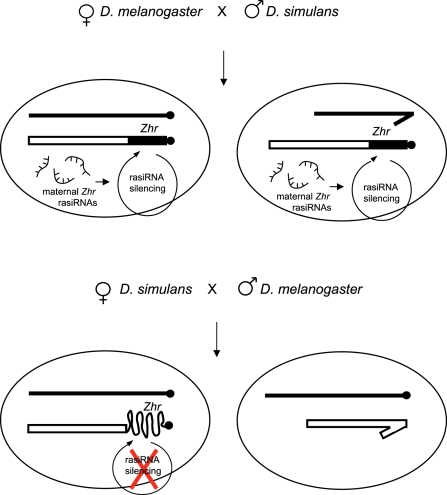
Model for the Role of RNAi in Hybrid Embryonic LethalityHybrid embryos produced from D. melanogaster mothers and D. simulans fathers inherit Zhr-derived rasiRNAs from the maternal cytoplasm. These small RNAs are required during the early embryonic divisions for proper silencing of the Zhr locus. In contrast, hybrid embryos from D. simulans mothers and D. melanogaster fathers do not contain maternally loaded Zhr rasiRNAs. As a result, Zhr is not silenced in hybrid females carrying the D. melanogaster X chromosome, resulting in heterochromatin decondensation and embryonic death. Hybrid male embryos from this cross do not carry the D. melanogaster X and thus are viable. We suggest that the 359-bp, 1.688-g/cm3 satellite corresponds to Zhr (see text for details).